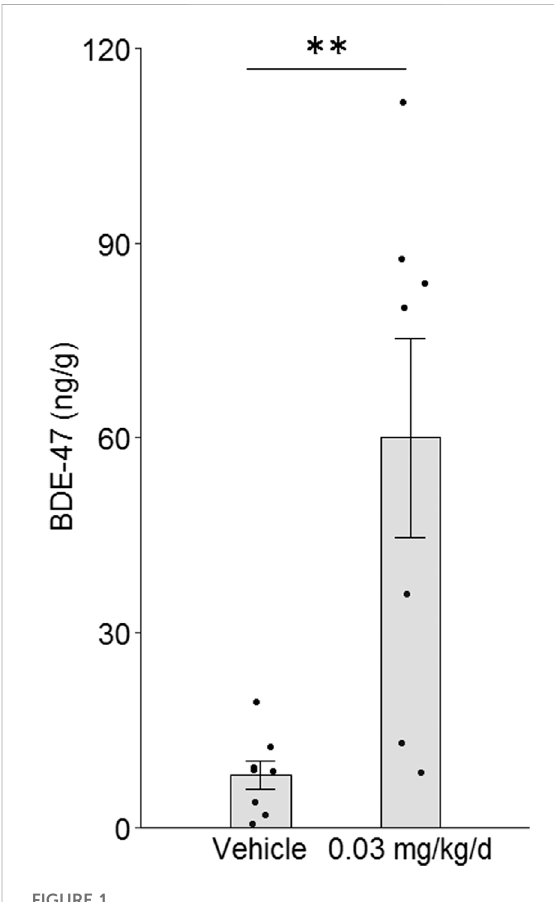
FIGURE 1 Effect of BDE-47 administration on mammary tissue levels. Mean ± SEM and individual data points for mice receiving 0.03 mg/kg/d of BDE-47 via subcutaneous osmotic mini-pump ( n = 7) or vehicle only ( n = 8) for 16 weeks ** p < 0.01.